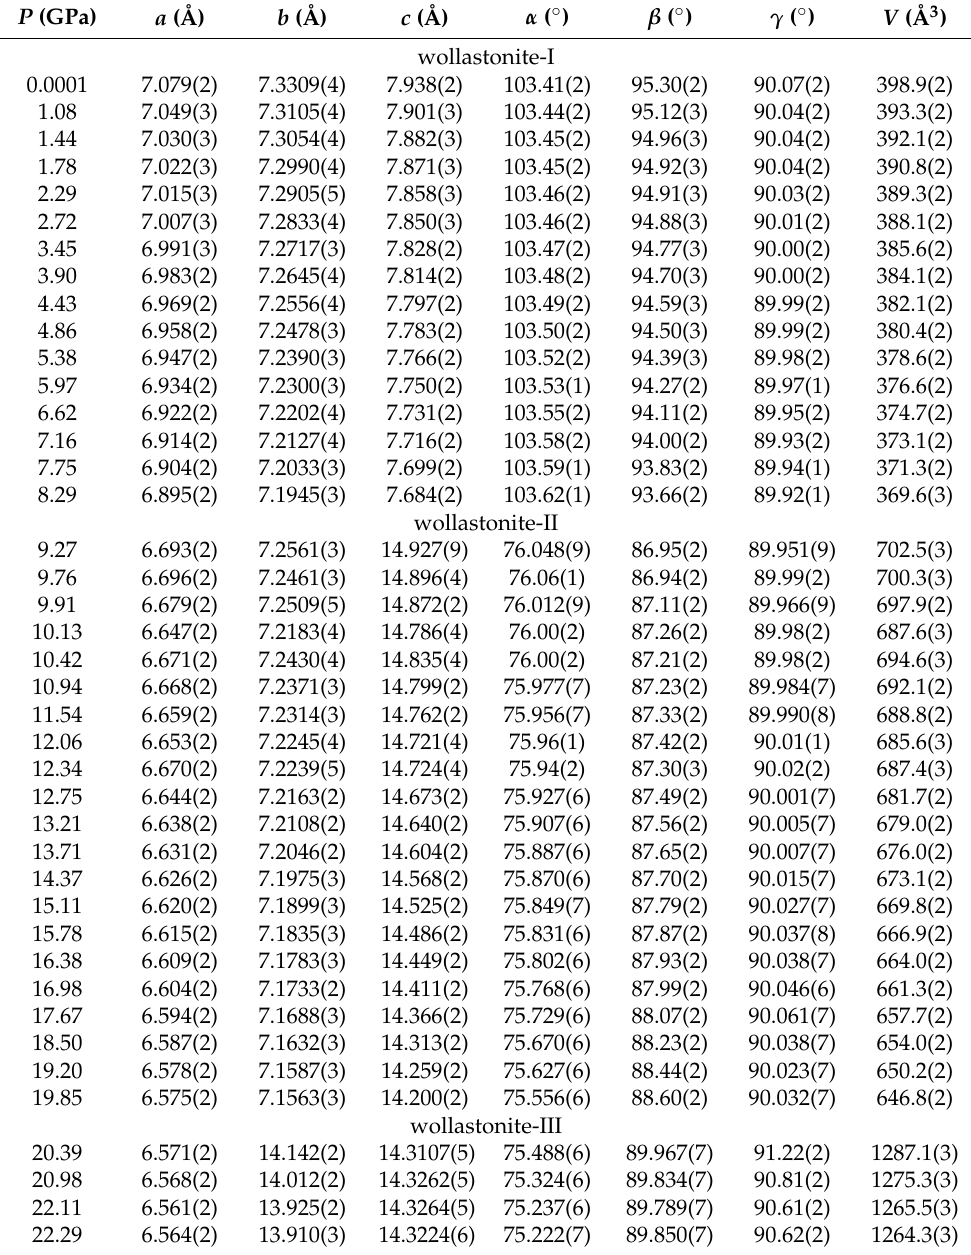
Table 2. Lattice parameters of wollastonite at different pressures, collected using helium as P - transmitting medium ( P -uncertainty: ± 0.05